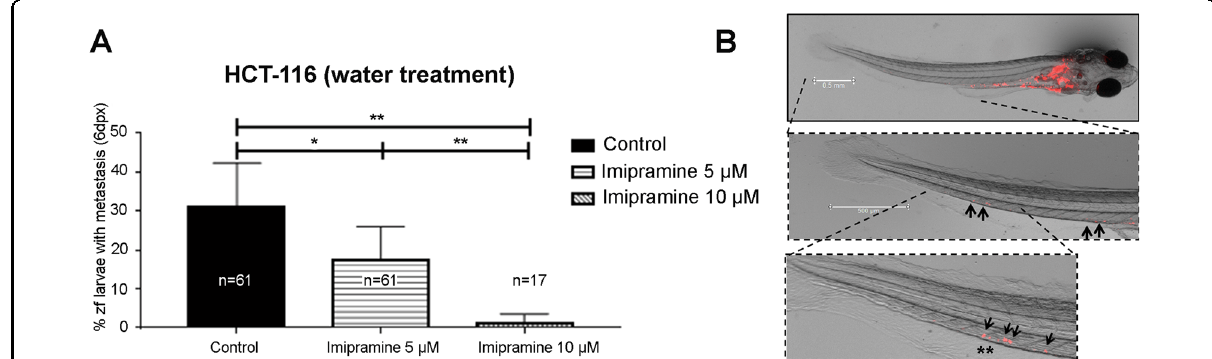
Fig. 8 Antimetastatic potential of imipramine in zebra fi sh. a At day 6 post injection, larvae were examined to evaluate whether micrometastasis developed by invading native HCT-116 cells. b The evaluation criteria were the presence of human cancer cell colonies (arrows) outside the yolk sac. Invading single cells are indicated by asterisks (*). Data are shown as the mean ± SD, compared with the control, * p = 0.049 – 0.01; ** p = 0.001 –